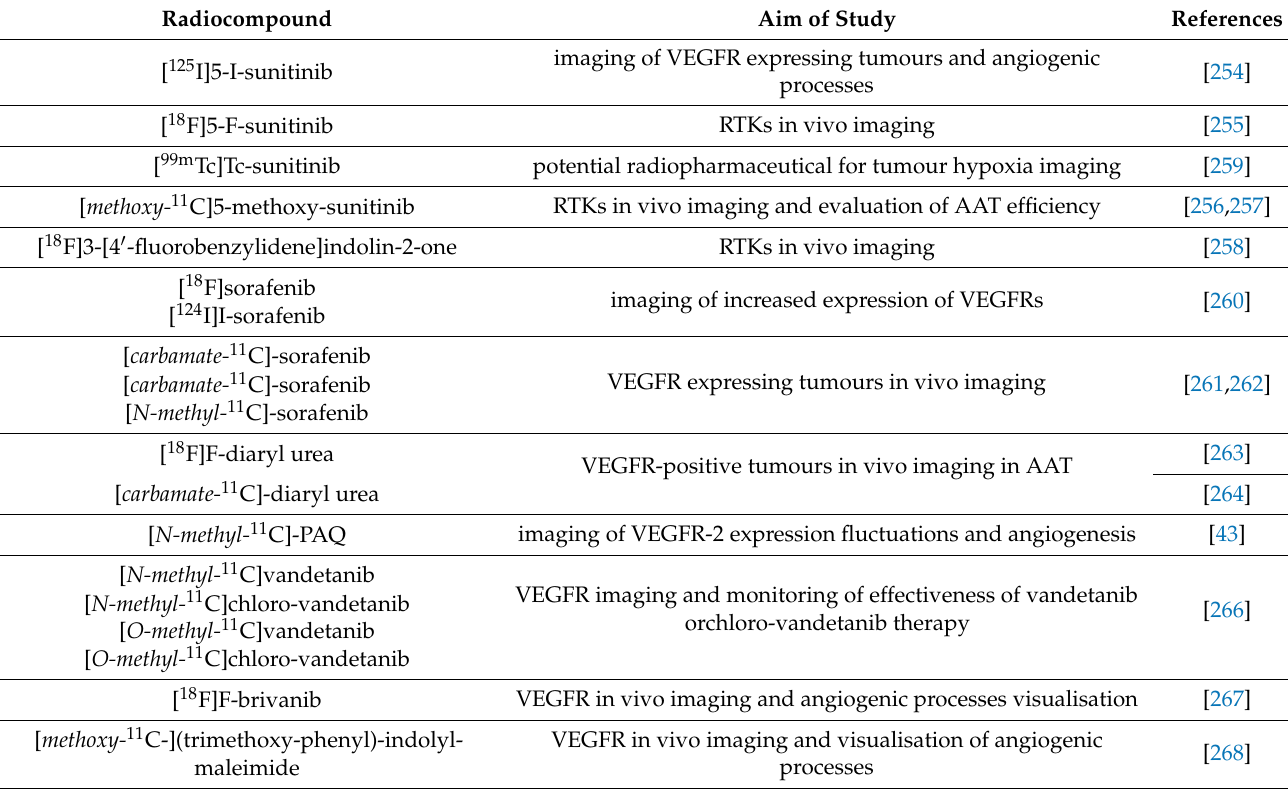
Table 4. Radiolabelled small molecular inhibitors of VEGFR tyrosine